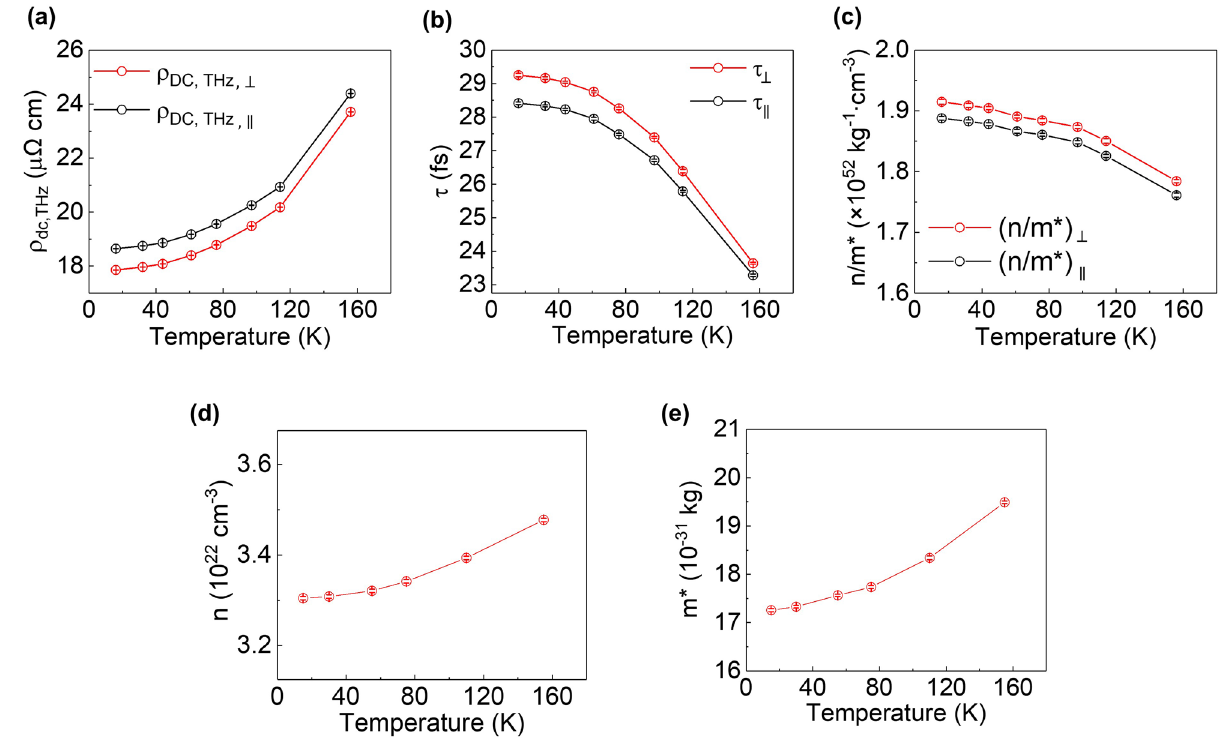
Figure 2. Temperature-dependent intrinsic and extrinsic transport parameters probed by THz-TDS. ( a ) THz-proved DC resistivity, ρ dc , THz , as a function of temperature for parallel (black) and perpendicular (red) geometries. ( b ) Temperature-dependent electron scattering time, τ , for parallel (black) and perpendicular (red) geometries. ( c ) Temperature-dependent charge density/effective mass, n / m ∗ , for parallel (black) and perpendicular (red) geometries. ( d ) Charge concentration, n , as a function of temperature obtained from ordinary Hall effect measurement. ( e ) effective mass, m ∗ , as a function of temperature. The error bars in ( a )–( e ) are smaller than the symbol